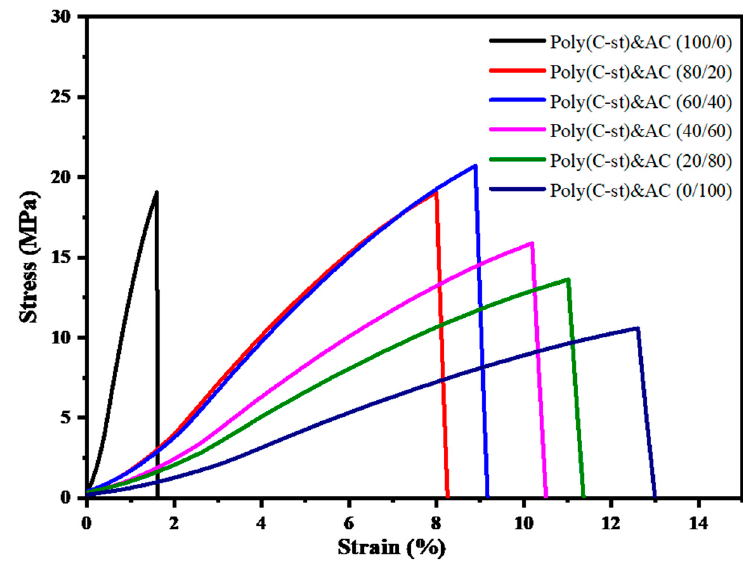
Table 3. Data obtained from stress–strain curves.